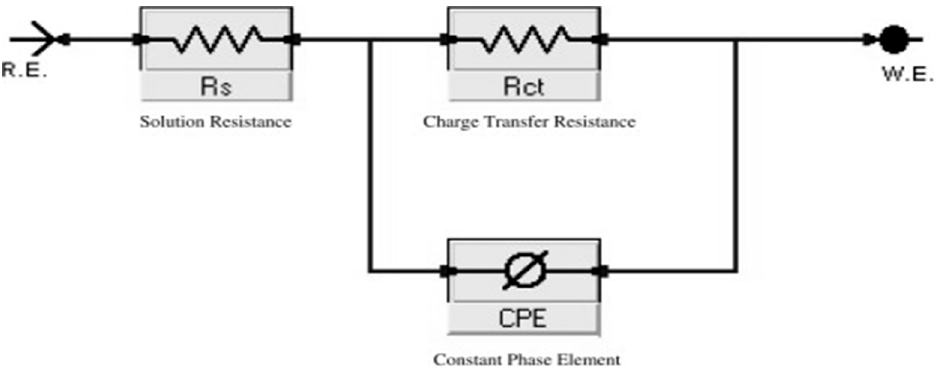
Figure 3. Equivalent circuit utilized to fit EIS data. Table 3. Parameters given by EIS test for Q235 steel in corrosive environments attendance and lack of unlike dose of spiropyrazoles derivatives. Cpd.